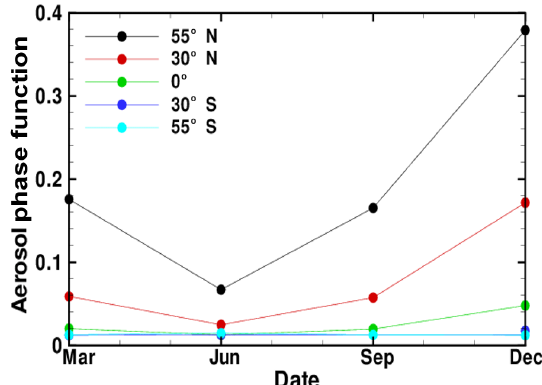
Figure 4. The seasonal variation of the aerosol phase function at several latitudes for the SNPP OMPS LP orbit. The aerosol size dis- tribution described in Table 1 for the V1 aerosol extinction retrieval algorithm is